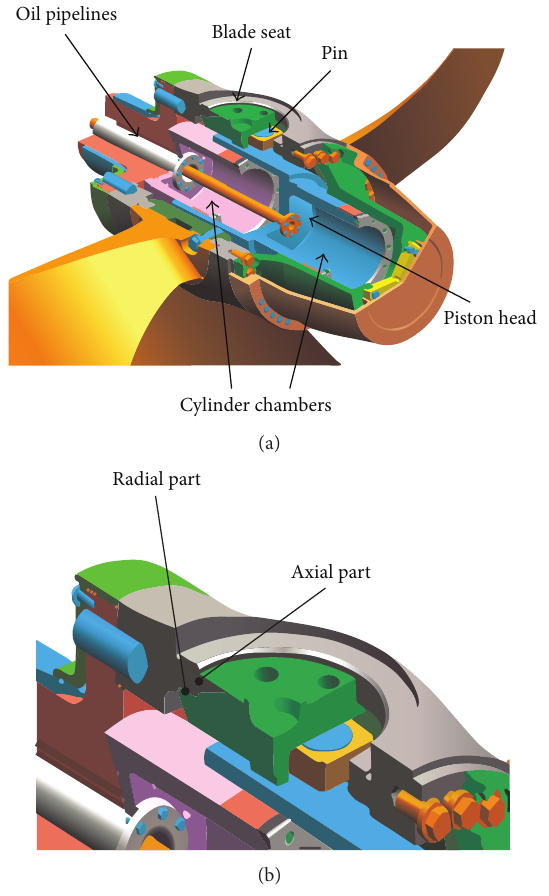
Figure 10: Main element inside a CPP hub (a). Blade seat (b) [9].